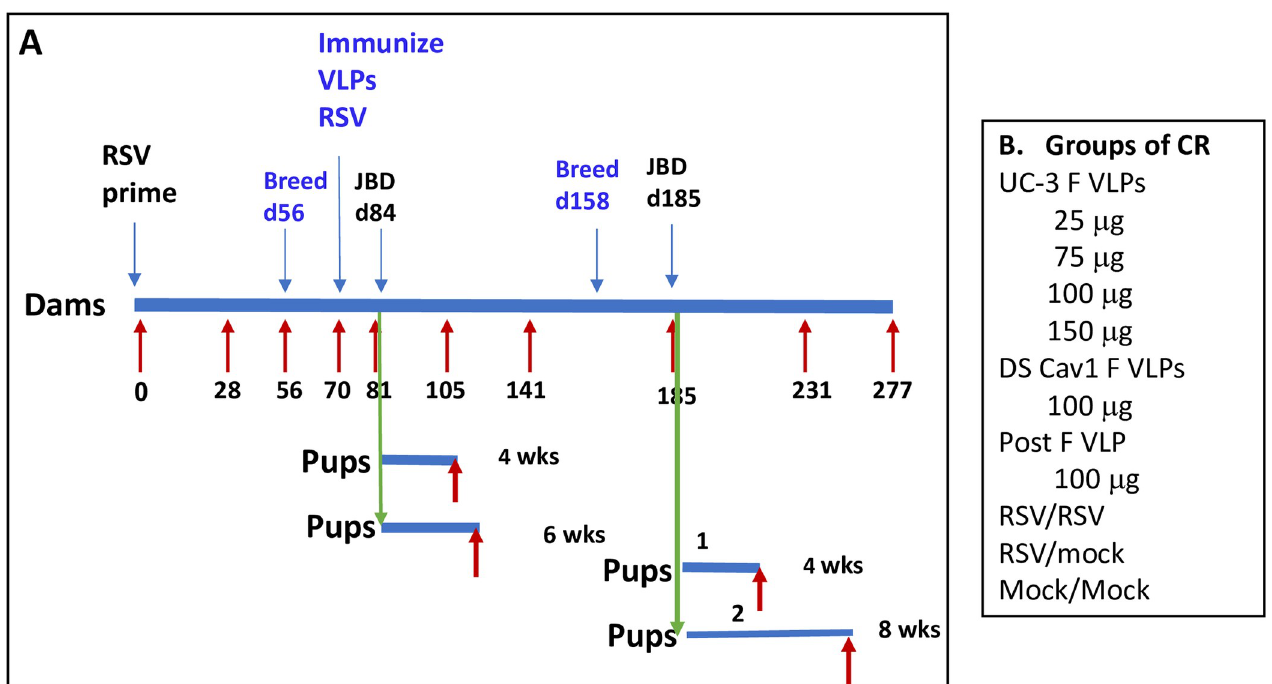
Fig 1. Experimental design. Panel A shows a diagram of the protocol to assess durability of maternal immunization. Groups of CR were primed with RSV (IN) at day 0. These animals were then bred twice, once at day 56, and the second at day 158. Groups of animals were immunized at day 70 with UC-3 F, DS-Cav1 F, or post F VLPs (in blue). Other groups were infected a second time with RSV or mock immunized (in blue). Offspring of dams were challenged with RSV at 4, 6, or 8 weeks after birth. Red arrows show times of serum acquisition. Panel B lists groups of dams (10